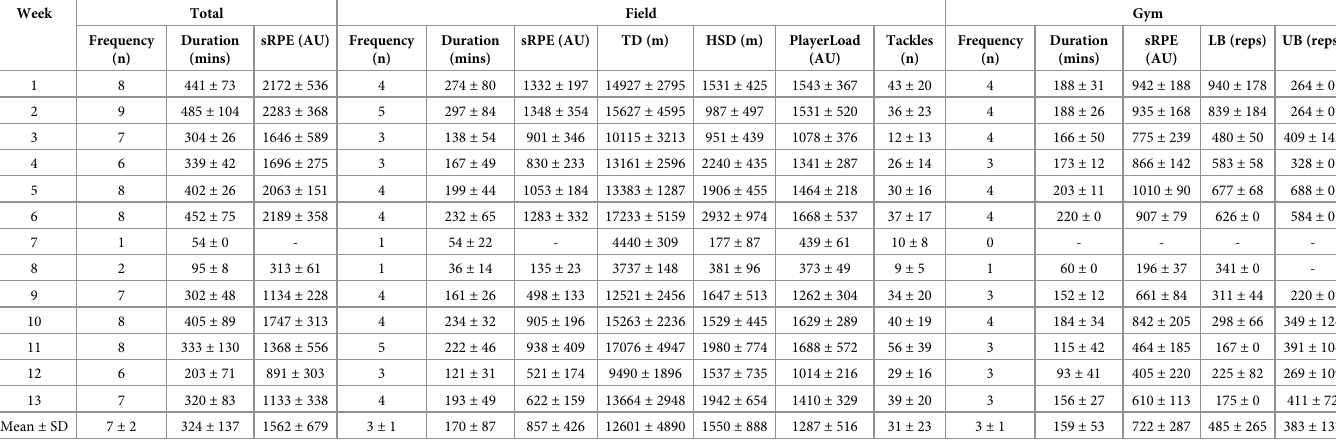
Table 1. Total (Mean ± SD) weekly training load during an academy rugby league pre-season.